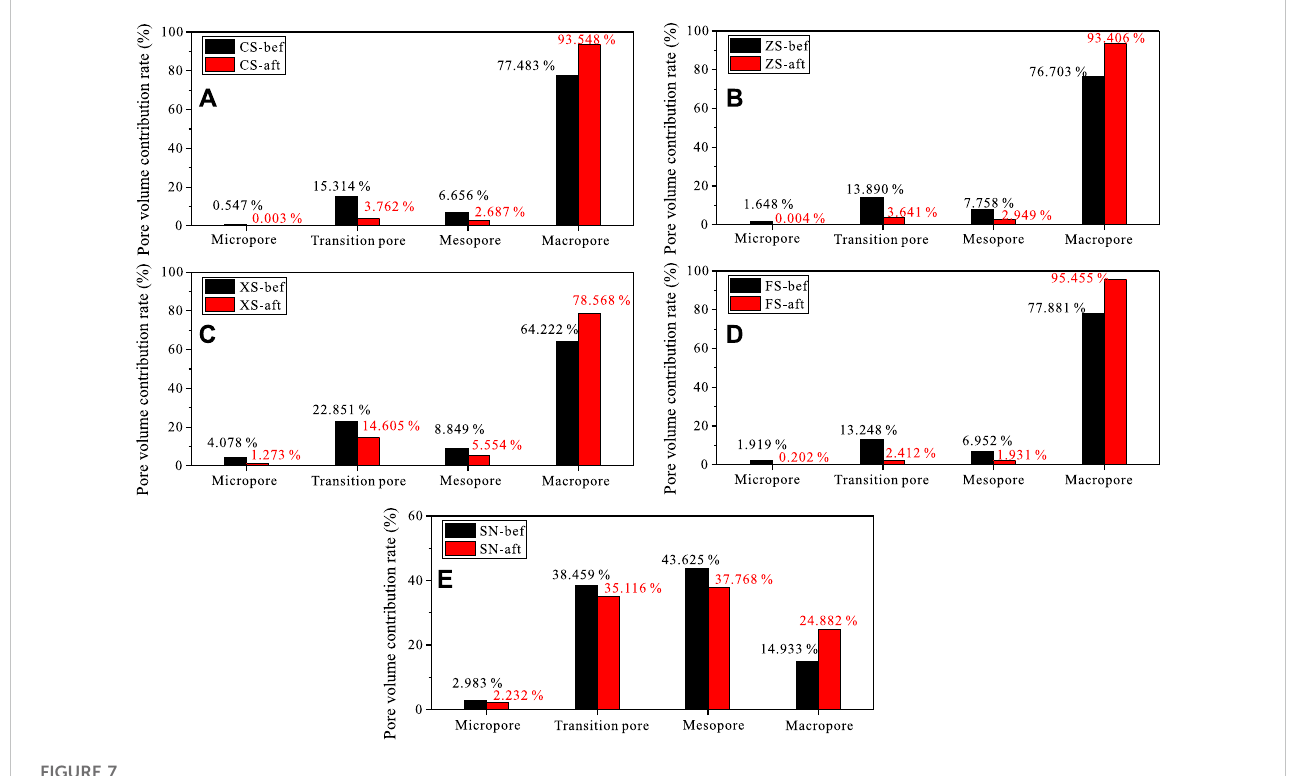
FIGURE 7 Pore volume contribution rate of samples: (A – E) represent the samples CS, ZS, XS, FS, and SN.